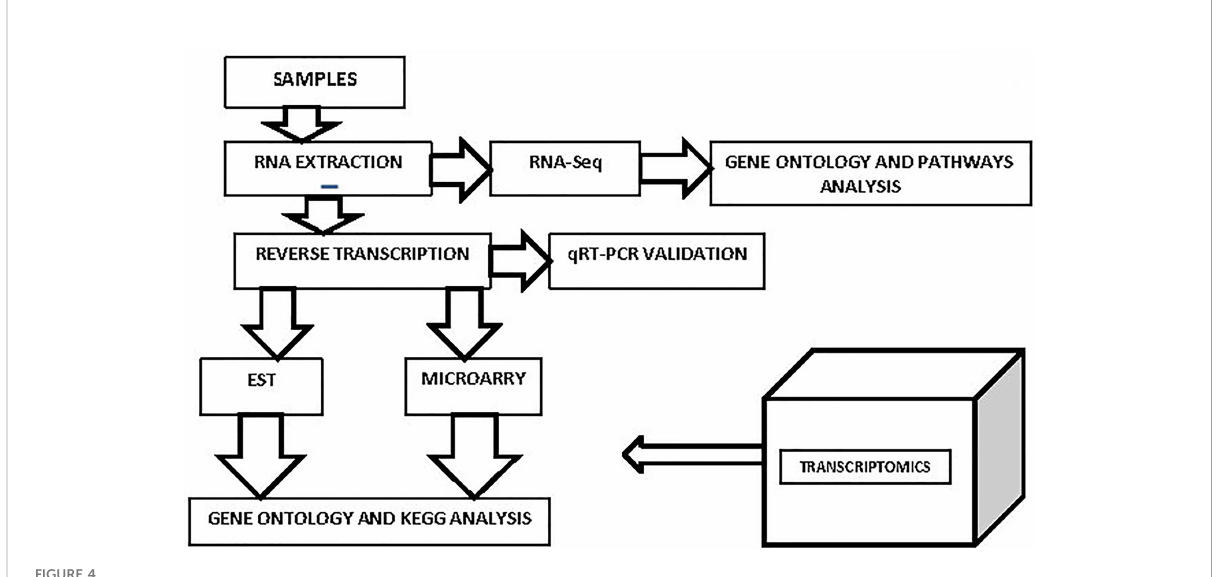
FIGURE 4 Work fl ow for transcriptomic techniques for crop improvement Transcriptomics entails the extraction of an organism ’ s total RNA at a speci fi c time point and under a speci fi c environmental situation, which is then processed differently for expression analysis. Reverse transcriptase is used to create cDNAs for EST and microarray research, and cDNA libraries are then created. For the purpose of creating ESTs and microarray probes for expression pro fi ling, this might be sequenced. If not, the total RNA could be normalised and sequenced in order to identify all the genes with differential expression. qRT-PCR offers additional validation. KEGG analysis and gene ontology aid in the functional connection of discovered